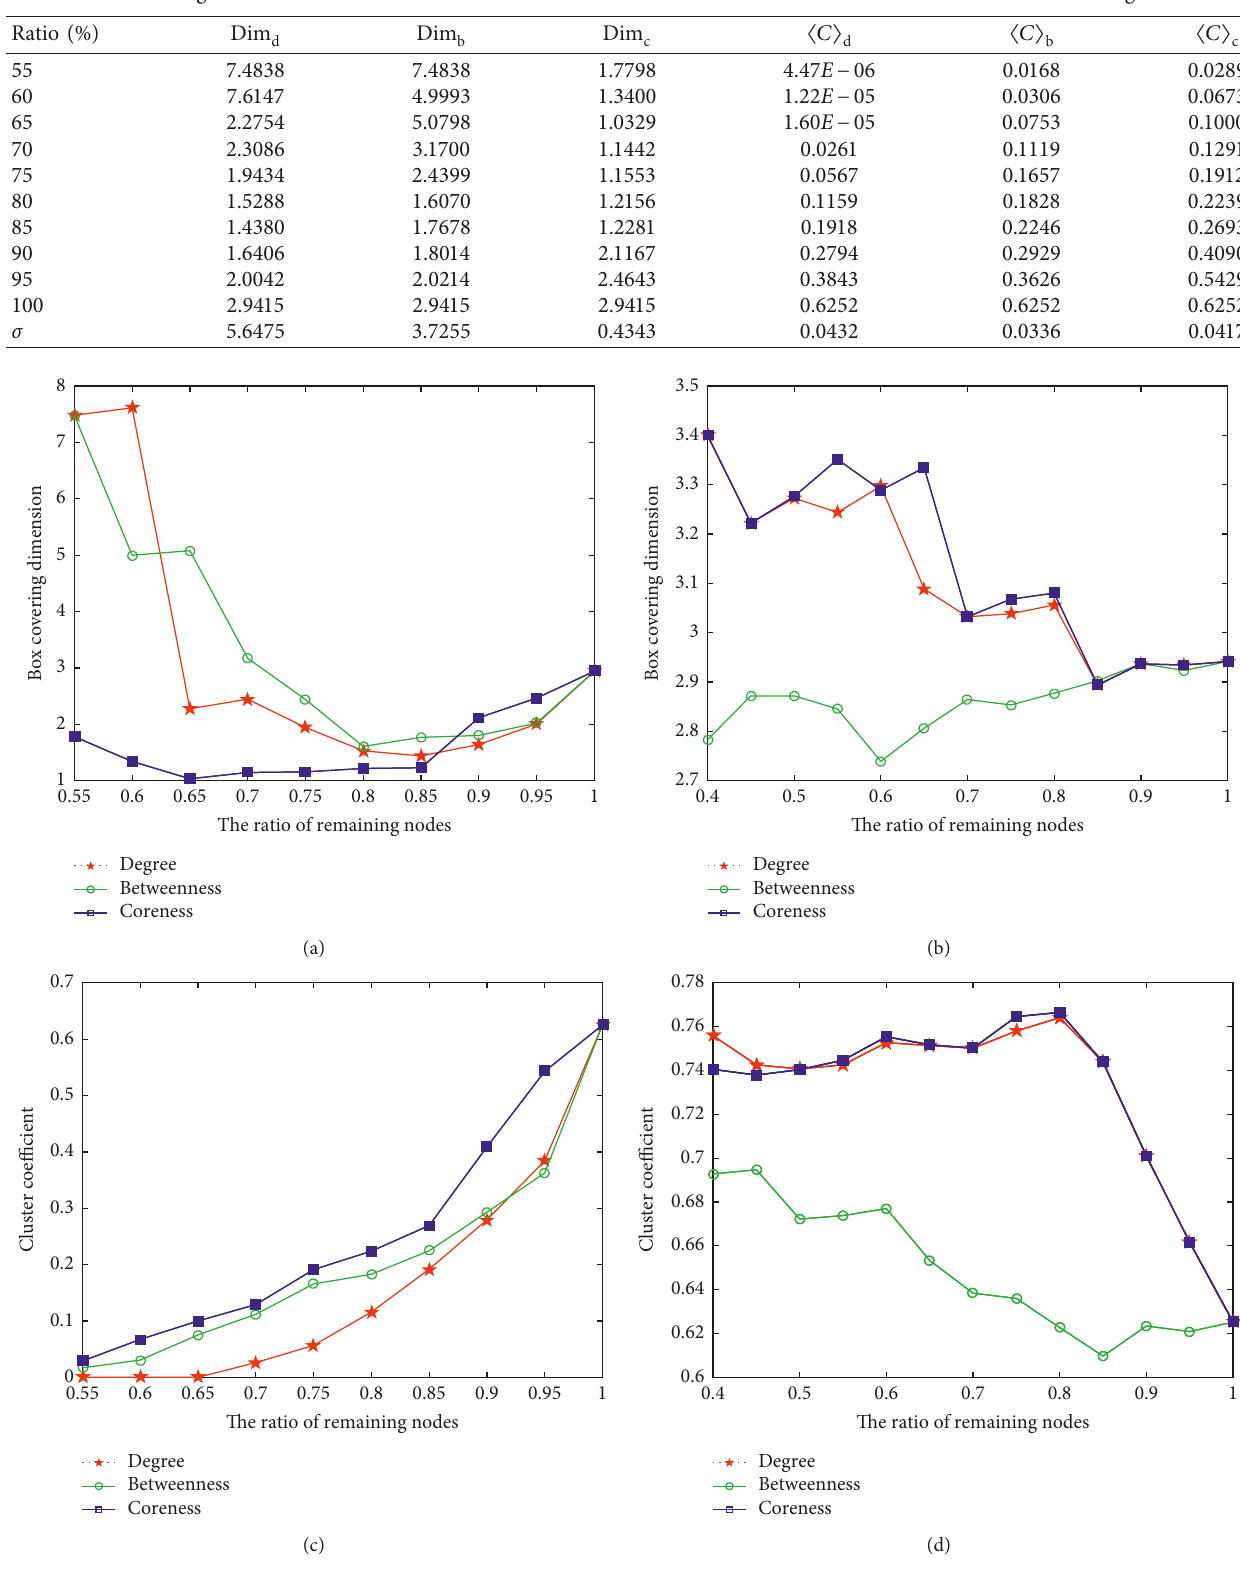
Figure 4: Changes of box dimension and cluster coefficient of USAir network, after nodes are removed by sorting. The X -axis represents the number of nodes remaining in the network. (a) Nodes are removed by degree, betweenness, and coreness in the descending order. 5% of the biggest nodes are removed from the network in each rank, and the dimension of remaining network is calculated. (b) Nodes are removed by coreness in the ascending order. 5% of the smallest nodes are removed from the network in each rank, and the dimension of remaining network is calculated. (c) The changes of cluster coefficient after nodes are removed by degree, betweenness, and coreness in the descending order. (d) The changes of cluster coefficient after nodes are removed by degree, betweenness, and coreness in the ascending